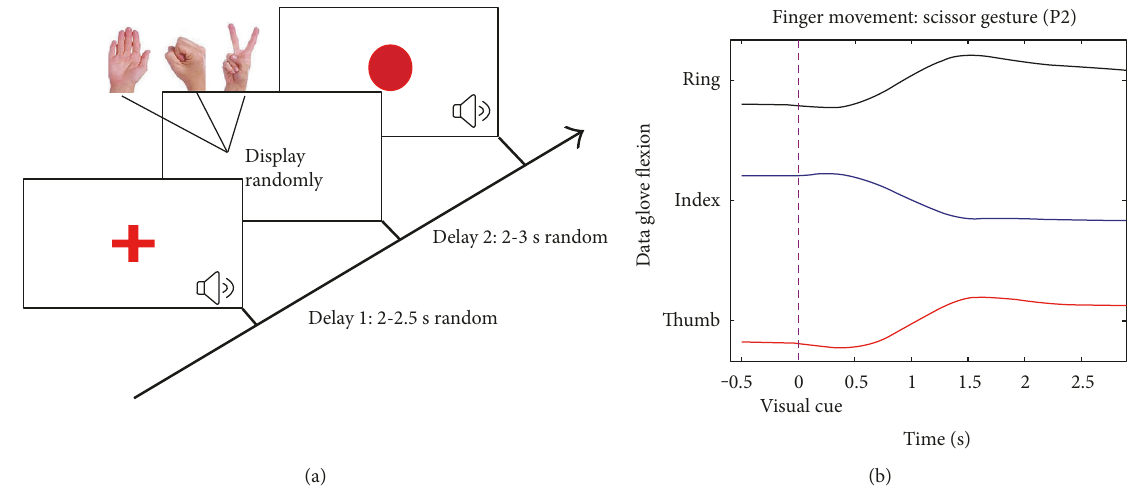
Figure 1: The behavioral task and recordings. (a) Hand grasp experimental paradigm. The trial was initiated by a red cross displayed on the center of the screen with a verbal cue “ ready. ” After a random delay ranging from 2 to 2.5s, the red cross disappeared and the gesture cue appeared on the screen, indicating the participant to replicate the gesture shown and hold on it until the red dot came out 2-3 seconds later. The correction of the trial was fed back by another verbal cue at the end of the trial. Three types of the gestures were displayed randomly and equally. (b) The fl exion of the data glove sensors on ring fi nger, index fi nger, and thumb. Purple dash line represented the timing when visual cue was